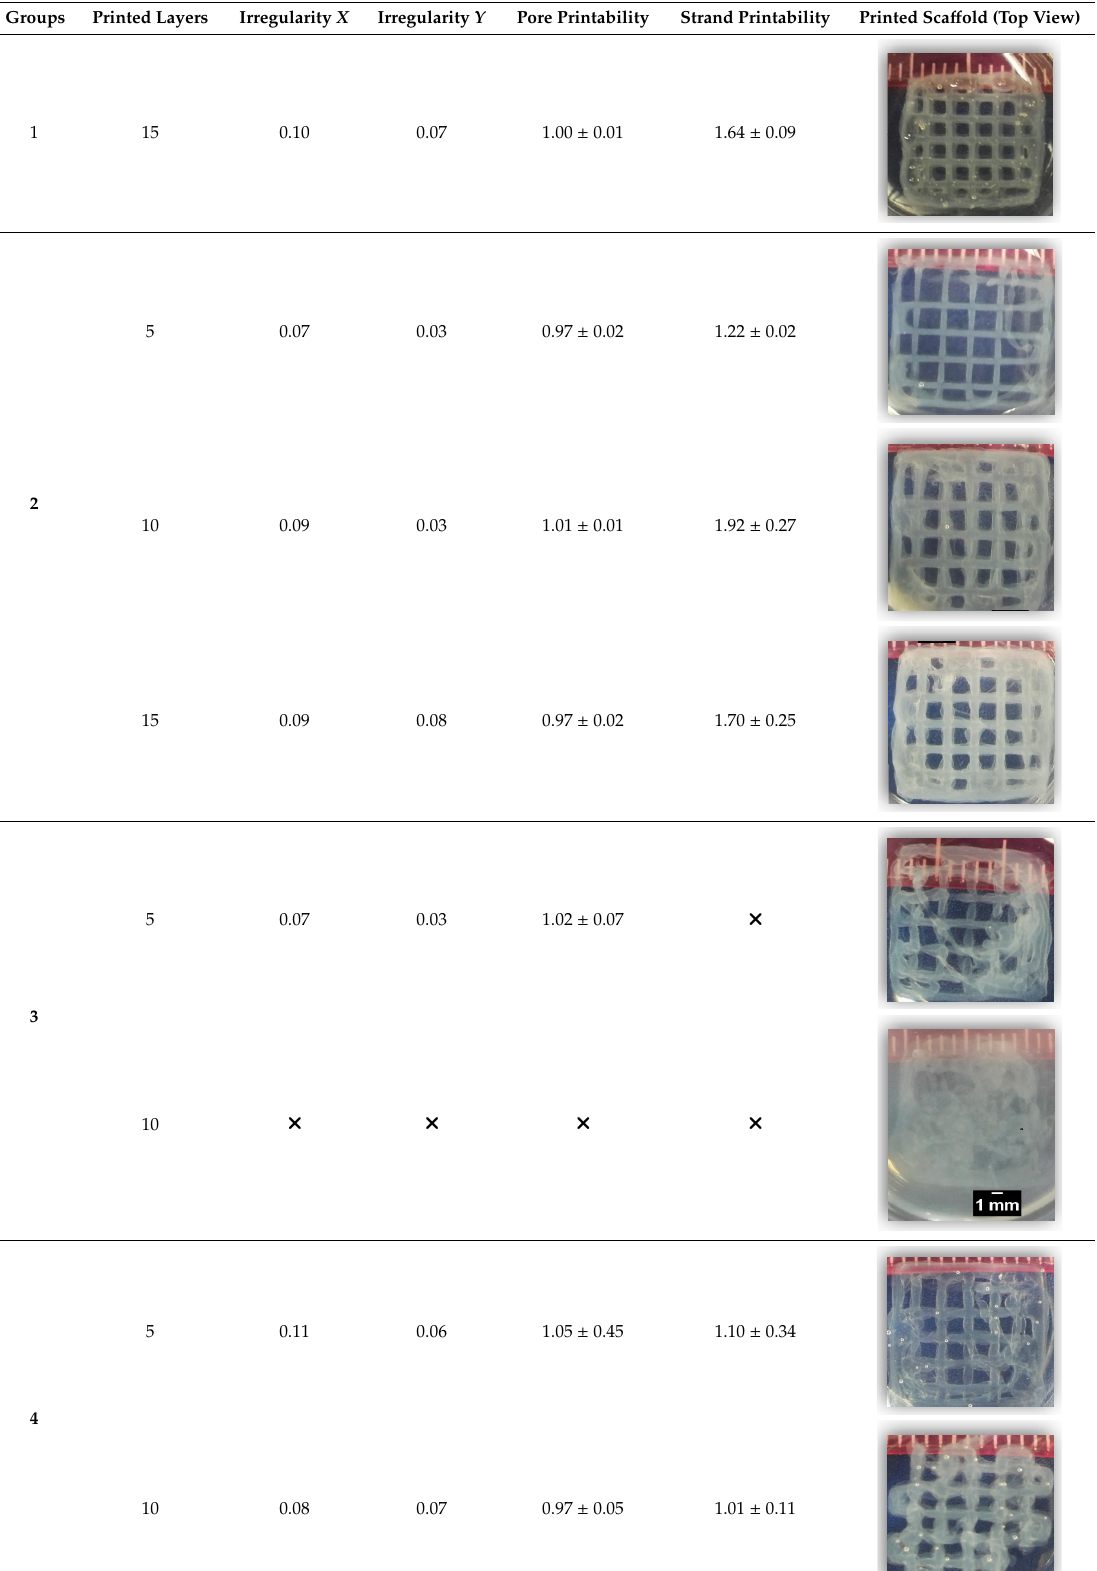
Table 3. The 3D printability results for the bioplotted scaffolds made from Groups 1 to 4.  shows that biomaterials are not printable or a large deviation is